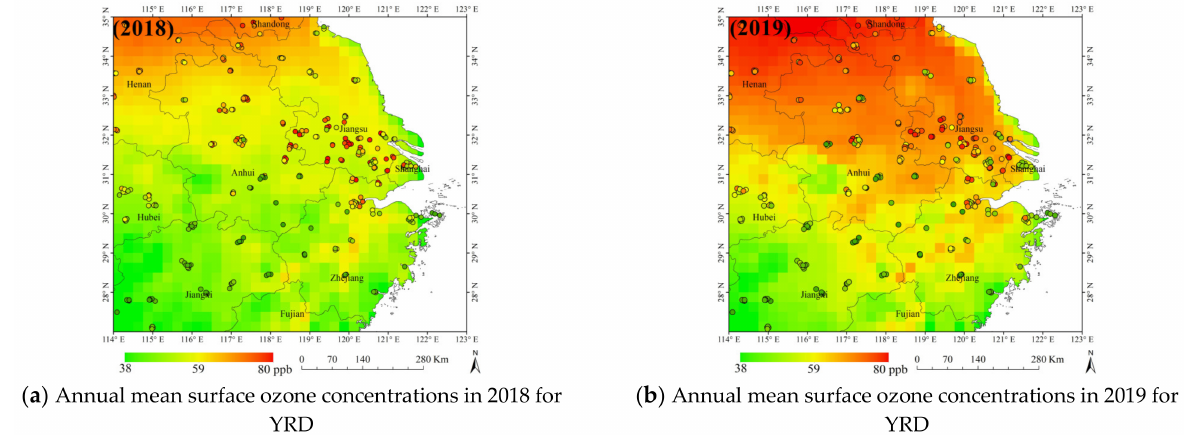
Figure 14. The map of 0.25 ◦ × 0.25 ◦ annual mean surface ozone concentrations in 2018 ( a ) and 2019 ( b ) for YRD; the colored dots represent the annual mean of concentrations of each surface ozone site from